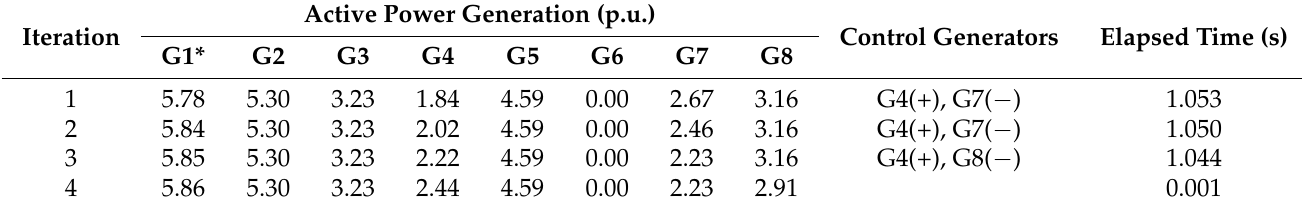
Table 2. The iteration process of adjustment.